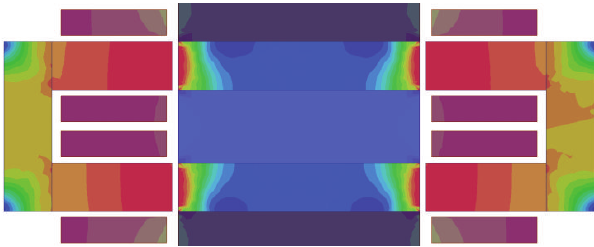
Figure 28: Magnetic flux density at 𝑡 = 40 ms.